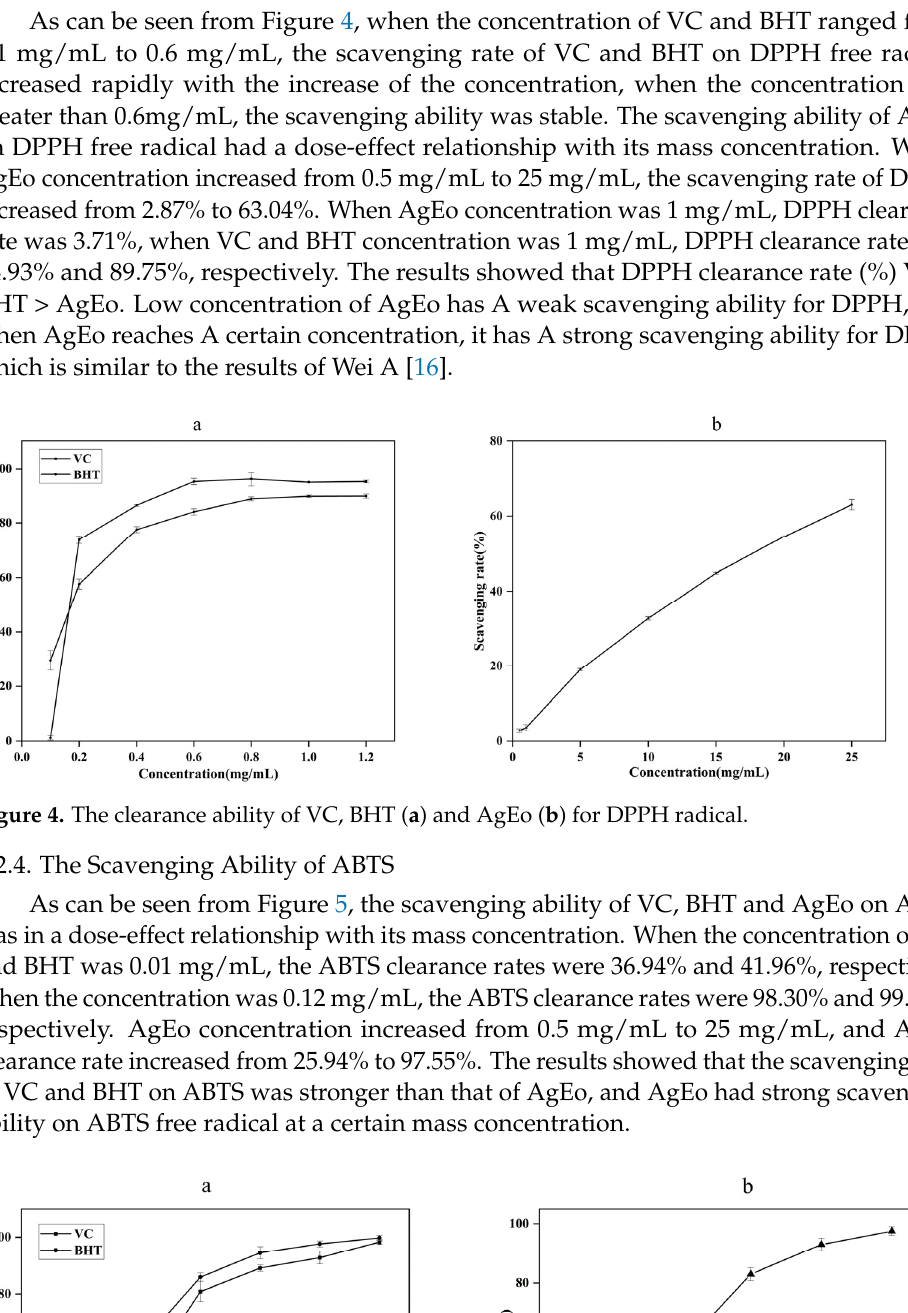
Figure 3. The clearance ability of VC, BHT ( a ) and AgEo ( b ) for hydroxyl radical.